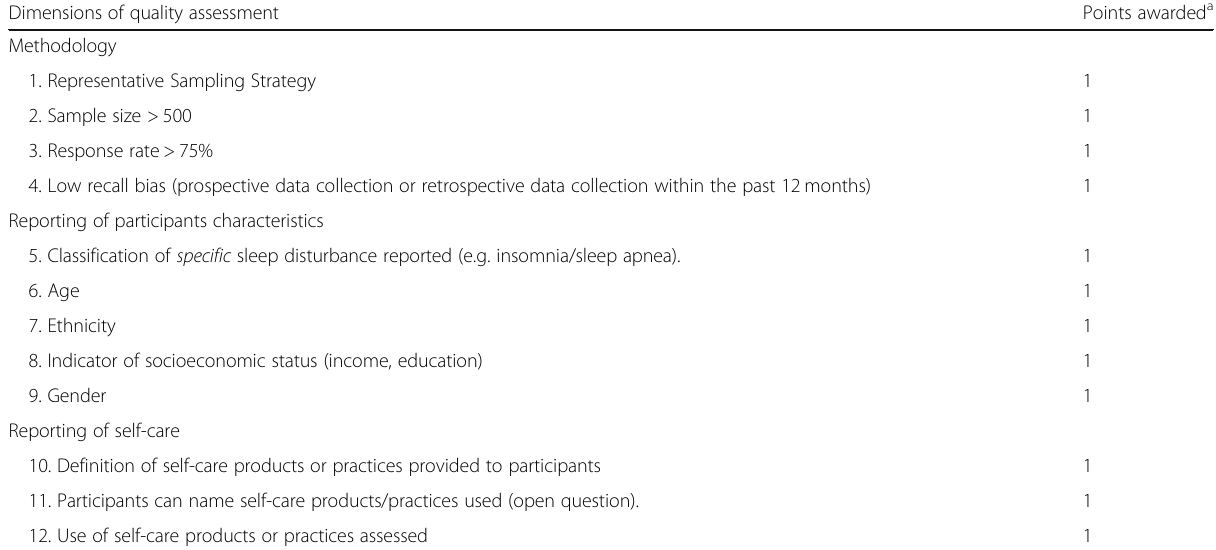
Table 2 Description of quality scoring system for the self-care surveys reviewed Dimensions of quality assessment